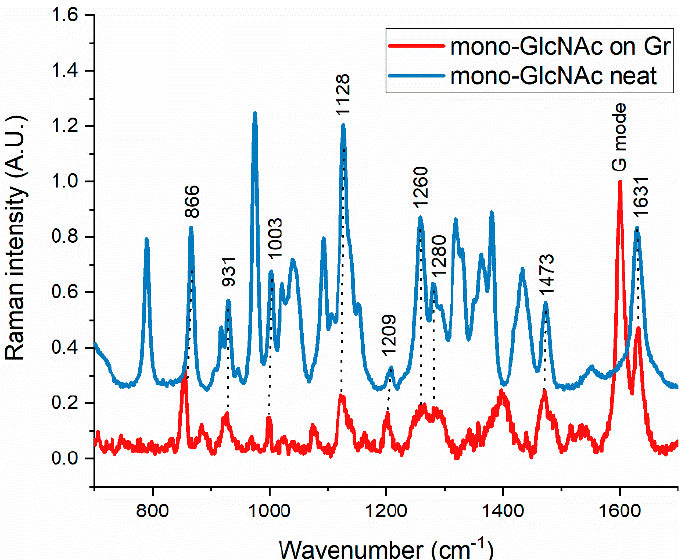
Figure 3. Comparison of Raman and surface-enhanced Raman spectra of mono-GlcNAc neat (blue) and grafted on graphene (red), respectively. Specific vibrations enhanced in the SERS mode are indicated in the spectra, e.g., amide I at 1631 cm − 1 , CH 2 deformation at 1473 cm − 1 , and C–H and C–OH deformation at 1128 cm − 1 . The signal assignment was performed according to the literature [34,35].